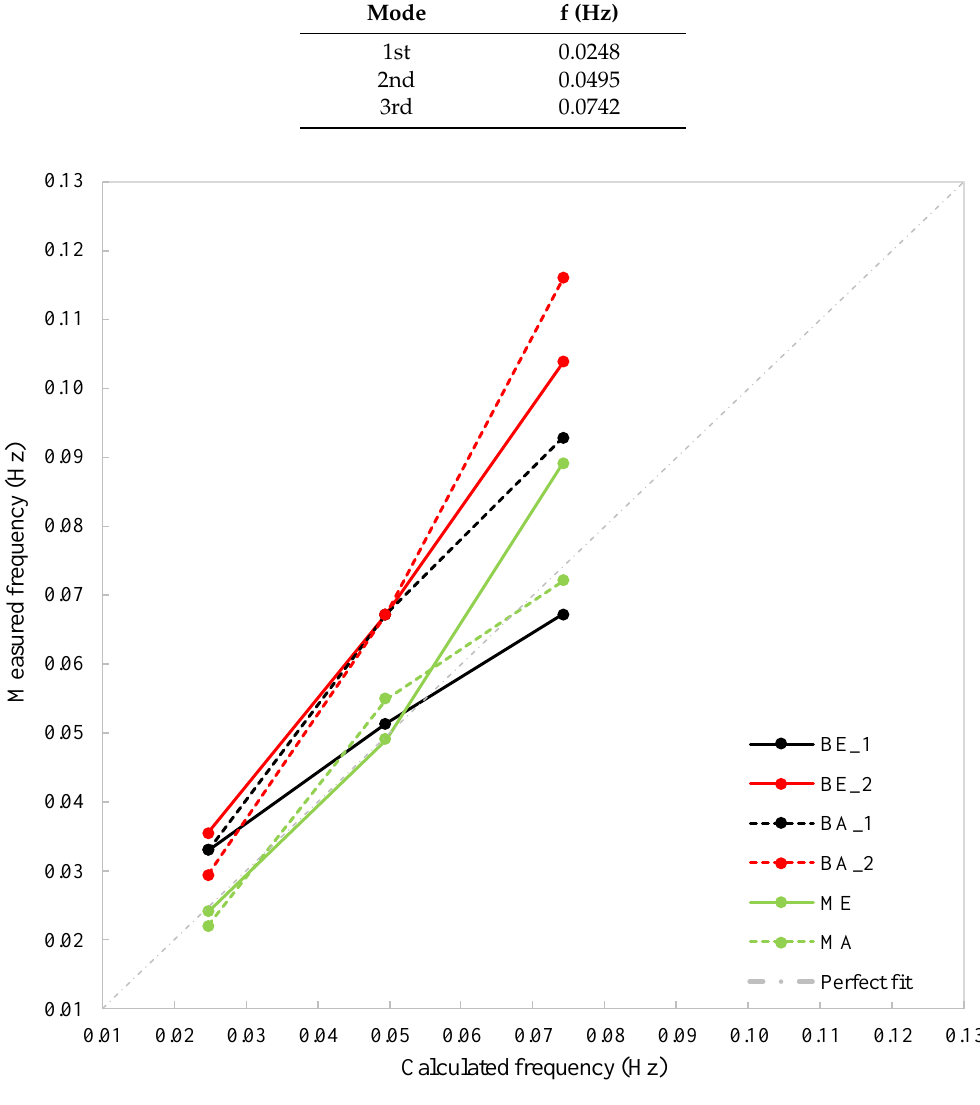
Figure 6. Frequencies plot of measured versus calculated first, second and third eigenmodes.